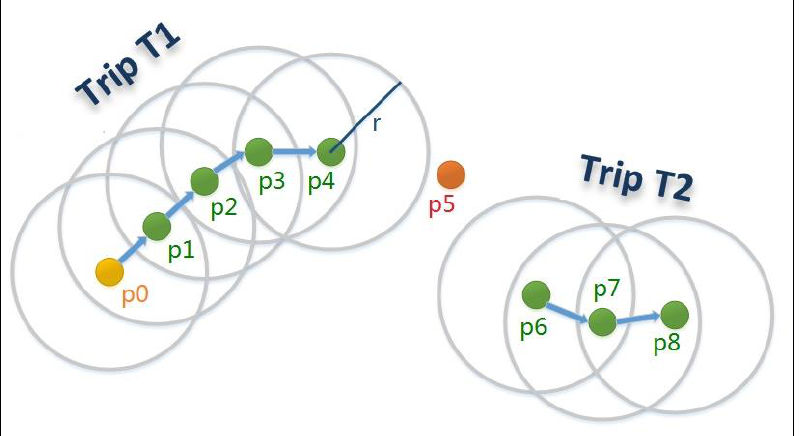
Figure 9. Generation of observed trips As highlighted, taxi status information is unavailable, while the dataset is provided as a series of continuous locations and timestamps for each taxi. This inhibits the comparison of travel times using the modelled versus observed approach. In order to create a meaningful comparison, we combine consecutive trajectories from the observational dataset to form taxi trips. We assume that taxi drivers would prefer to choose the shortest path based on their experiences and awareness of the congested network